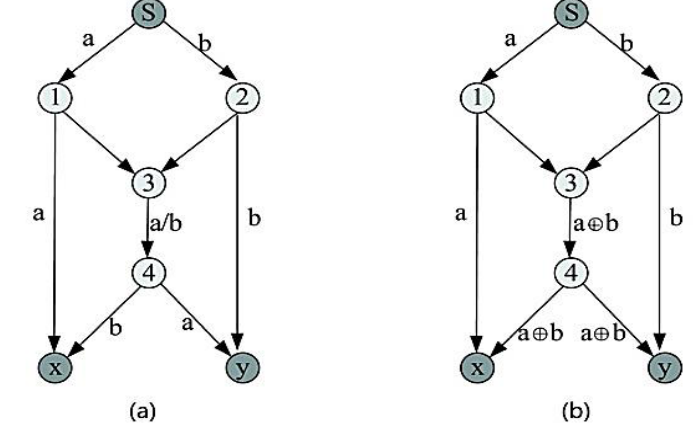
Figure 6. Comparison between coding and routing: ( a ) Store-and-forward method. ( b ) Coding